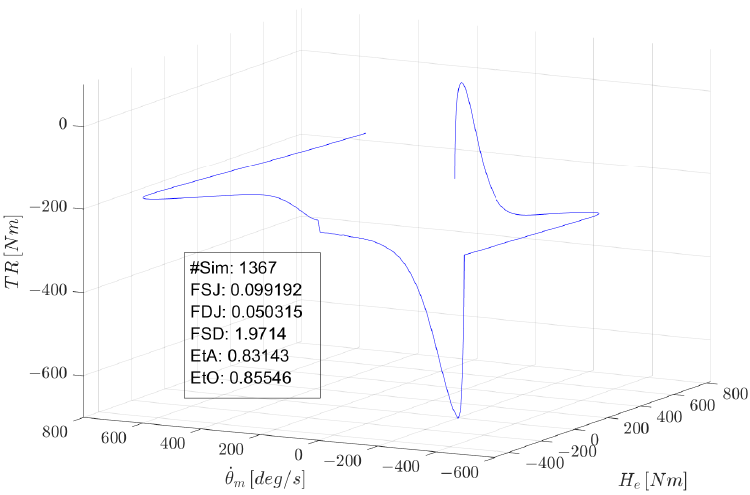
Figure 8. Trends of T R , H e and ˙ θ m shown in a 3D space. The box shows the ID of the simulation this graph refers to and the values of the parameters used for the